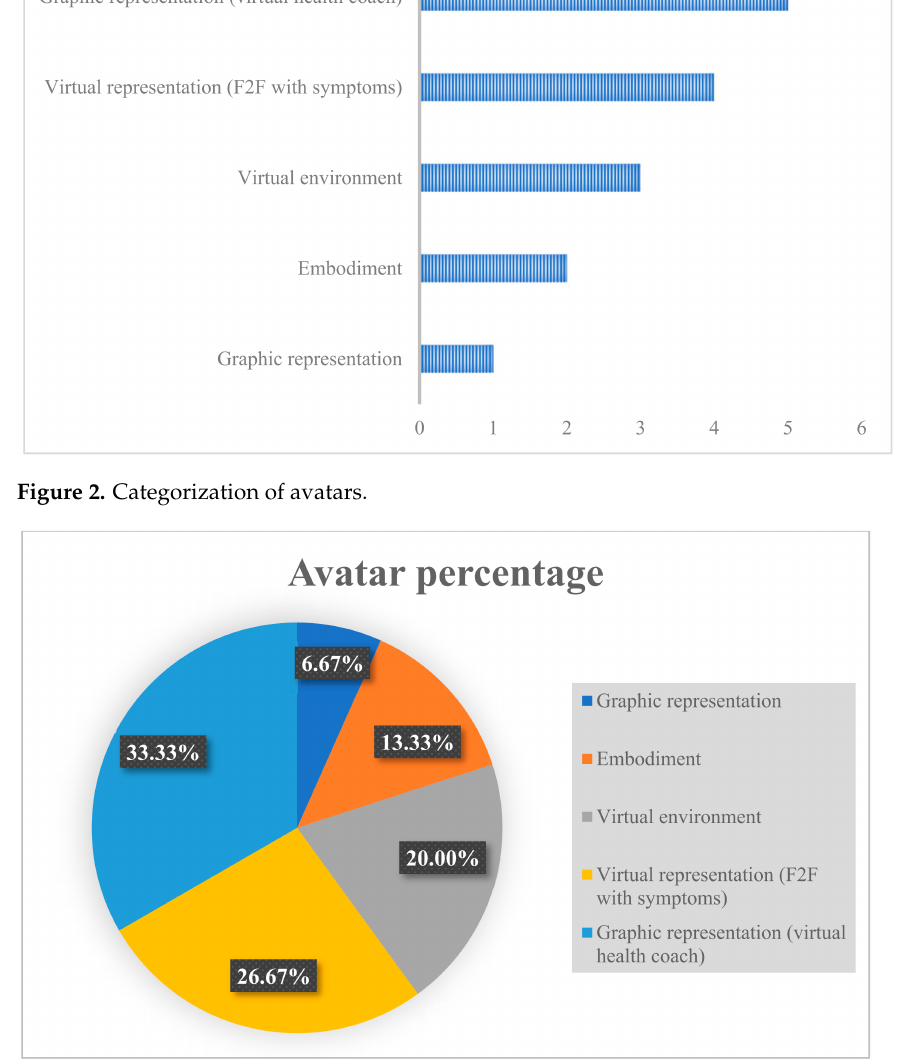
Figure 3. Avatar